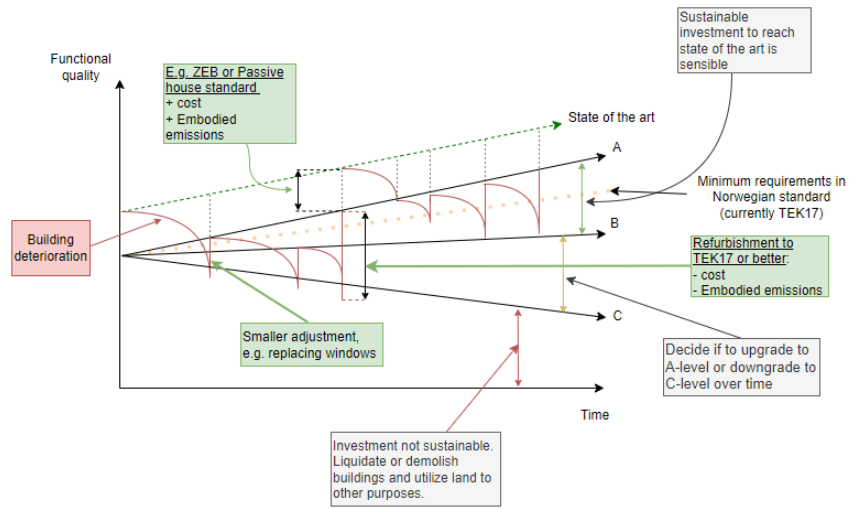
Figure 1. ABC-framework adapted from Svein Bjørberg in [20].